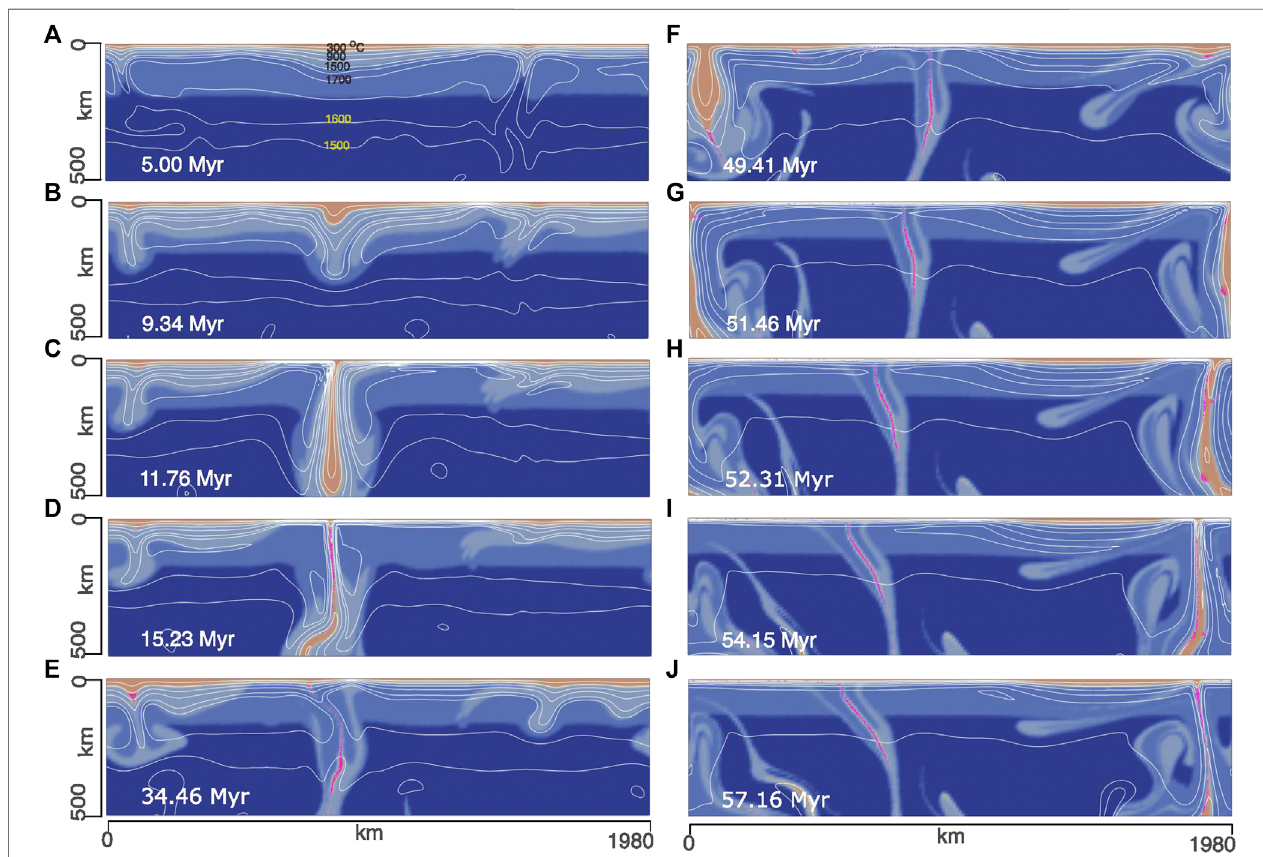
FIGURE4| Evolutionofthereferencemodelwithasurfaceyieldstressof50 MPa,mantleT p of1,600 ° CandMoho-Tof600 ° C.Mantleconvectiondrivesthickening of the basaltic crust (A) , which eventually transform into a Rayleigh-Taylor type instability (B) and drips into the mantle (C – E) . This cycle of crustal thickening followed by dripping continues. The residue forms during the production of tonalite-trondhjemite-granodiorite melt is shown in pink color. Within a period of ∼ 60 Myr, the model shows two major dripping phases: the fi rst phase (B – E) between ∼ 9 and 34 Myr and the second phase (F – J) between ∼ 49 and 57 Myr. Note that this second phaseistransferredacrossthe(periodic)boundaryfromlefttorightinthemodel (G – H) aroundthe ∼ 51 – 52 Myrtime-period.TheTTGformationmostlyoccursduringthe dripping phase as compared to the thickening phase.